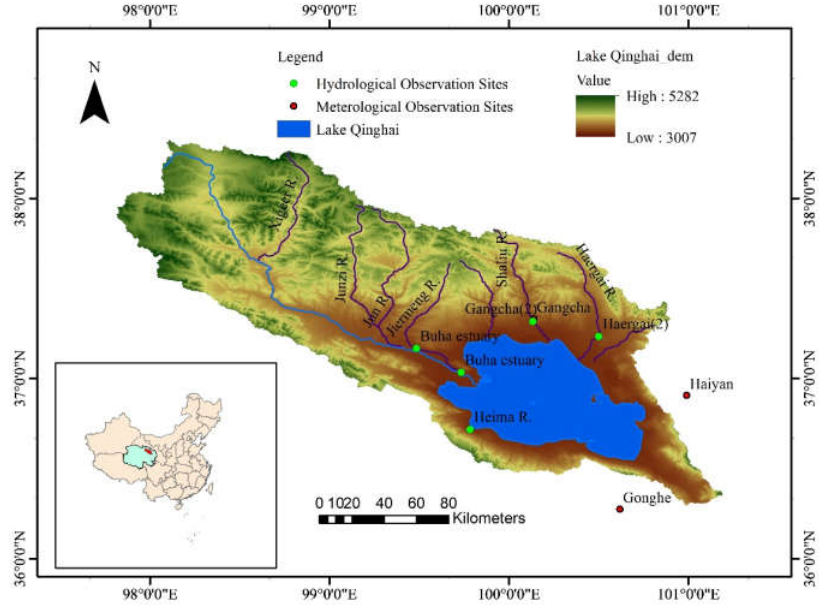
Figure 1. Location of the Qinghai Lake Basin.